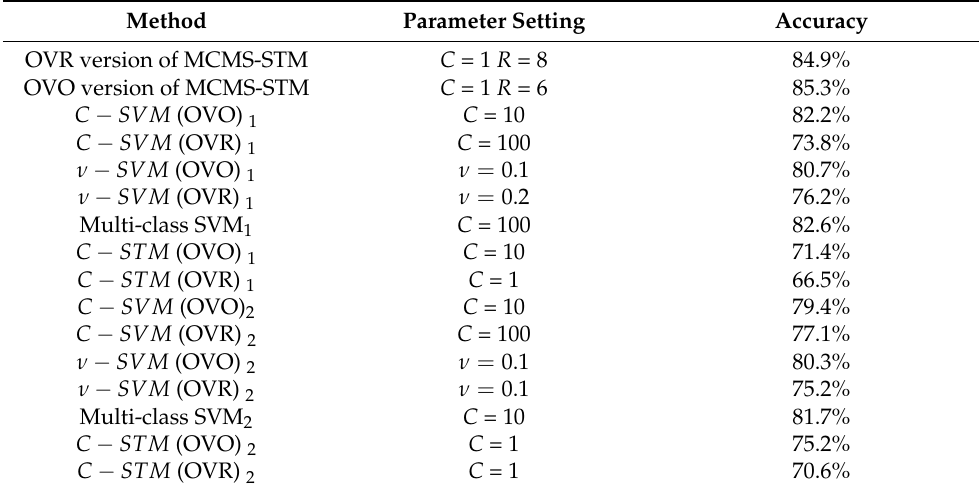
Table 3. The accuracies of different methods for multiscale airplanes recognization using 5-fold cross-validation.